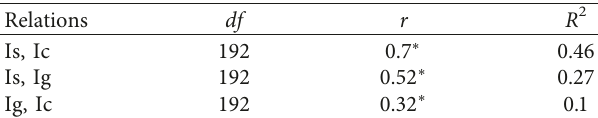
Table 6: Relations between indices of Solonchaks, Calcisols, and